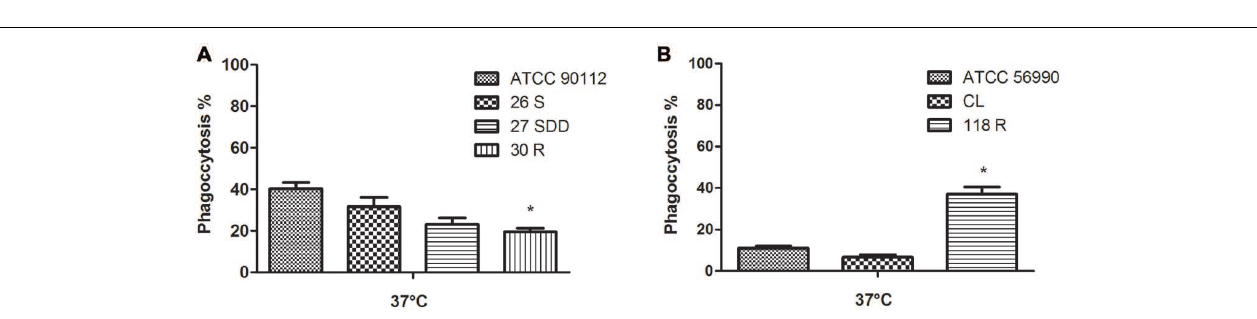
FIGURE 7 | Microscopy of C. neoformans and C. gattii isolates with India ink stain before (D0) and after infection in G. mellonella (D1, 24 h) and (D3, 72 h); (A) C. neoformans ATCC 90112; (B) C. neoformans isolate 26S; (C) C. neoformans isolate 27SDD; (D) C. neoformans isolate 30R; (E) C. gattii ATCC 56990; (F) C. gattii isolate CL; and (G) C. gattii isolate 118R.